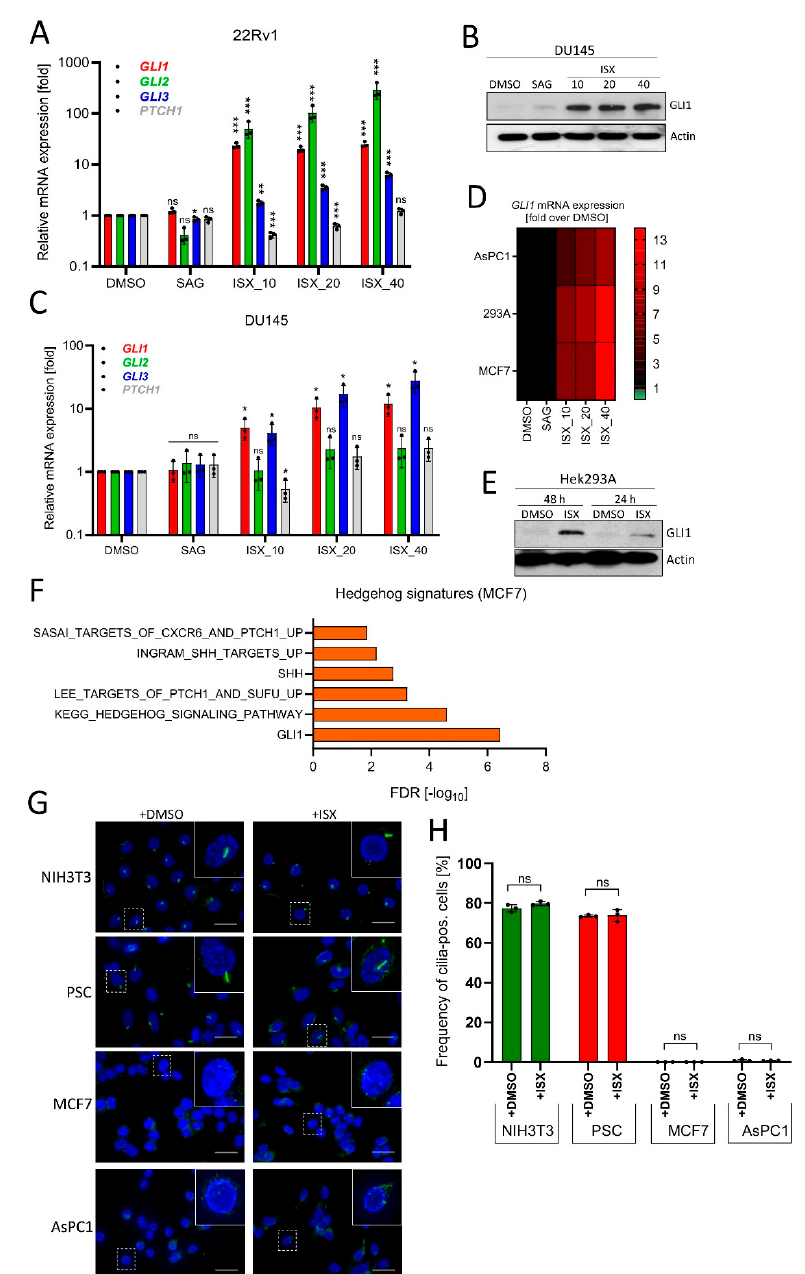
Figure 5. ISX activates GLI1 in a wide range of cell types. ( A ) Expression of Hh pathway genes in human prostate carcinoma cells (22Rv1). Treatment for 48 h with the indicated concentration of ISX (i.e., ISX_10: 10 µ M ISX). SAG: 100 nM. Mean of n = 3 ± SD. ( B ) GLI1 immunoblot of treated DU145 cells. ISX concentrations (numbers) in [ µ M]. SAG: 100 nM. ( C ) Expression of Hh pathway genes in human prostate carcinoma cells (DU145). Treatment for 48 h with the indicated concentration of ISX (i.e., ISX_10: 10 µ M ISX). SAG: 100 nM. Mean of n = 3 ± SD. ( D ) Heatmap summary of GLI1 expression (qPCR) in pancreatic AsPC1, breast MCF7 and kidney Hek293A cells. ISX concentrations [ µ M] as in (A). SAG: 100 nM. Shown is the mean of n = 3 (AsPC1; 293A) and n = 2 (MCF7) experiments. ( E ) GLI1 protein immunoblot of Hek293A cells treated for the indicated times. ISX: 20 µ M. Shown is one representative example of two. ( F ) Hh-related transcriptome signatures (RNAseq) of ISX (20 µ M, 48 h)-treated MCF7 cells versus DMSO control. ( G ) Primary cilia (AcTub, green) in various cell lines. Treatment with 20 µ M ISX for 48 h. Nuclei appear in blue (DAPI). Scale bar is 10 µ m. ( H ) Quantification of primary cilia as seen in ( G ). Shown is the mean of n = 3 experiments with at least 100 cells being counted for each condition in each experiment. Significances were indicated as ns (not significant; p > 0.05), * p < 0.05, ** p < 0.01, *** p <